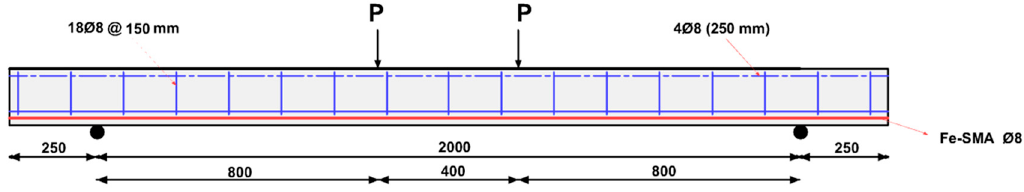
Figure 2. Test set-up of the beams (in mm) [14].